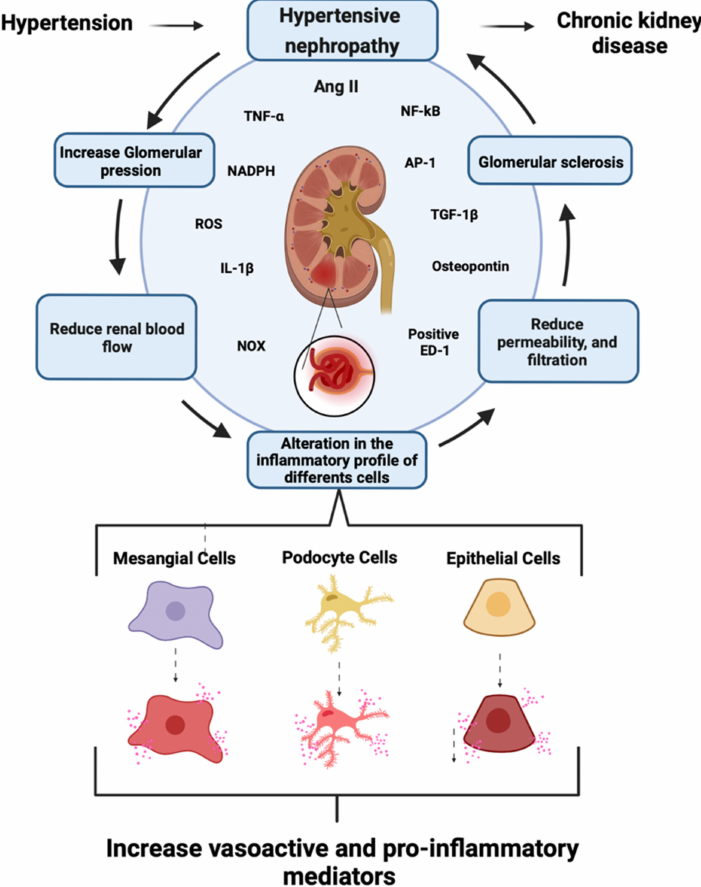
Figure 2. Schematics showing general aspects of the generation of chronic kidney disease mediated by hypertensive nephropathy. At the renal level, arterial hypertension increases intra-glomerular pressure, leading to reductions in renal blood flow and alterations in the inflammatory profile of mesangial cells, podocytes, and epithelial cells. The epithelial cells boost the production of vasoactive and pro-inflammatory mediators, triggering a reduction in glomerular permeability and filtration. Consequently, hypertensive nephropathy can contribute to CKD. Renal impairment would then be associated mainly with the persistent production of AngII, which could augment the expression of proinflammatory cytokines [IL-1 β and TNF- α ] and the NOX-mediated generation of ROS. These processes likely result in macrophage infiltration and tubular overexpression of osteopontin, favoring the production of TGF- β 1 and activation of NF- κ B and AP-1. Elaborated in BioRender.com (accessed on 15 October